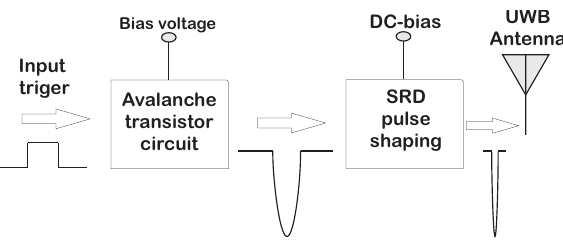
Figure 1: The circuit schematic of the pulse generator.